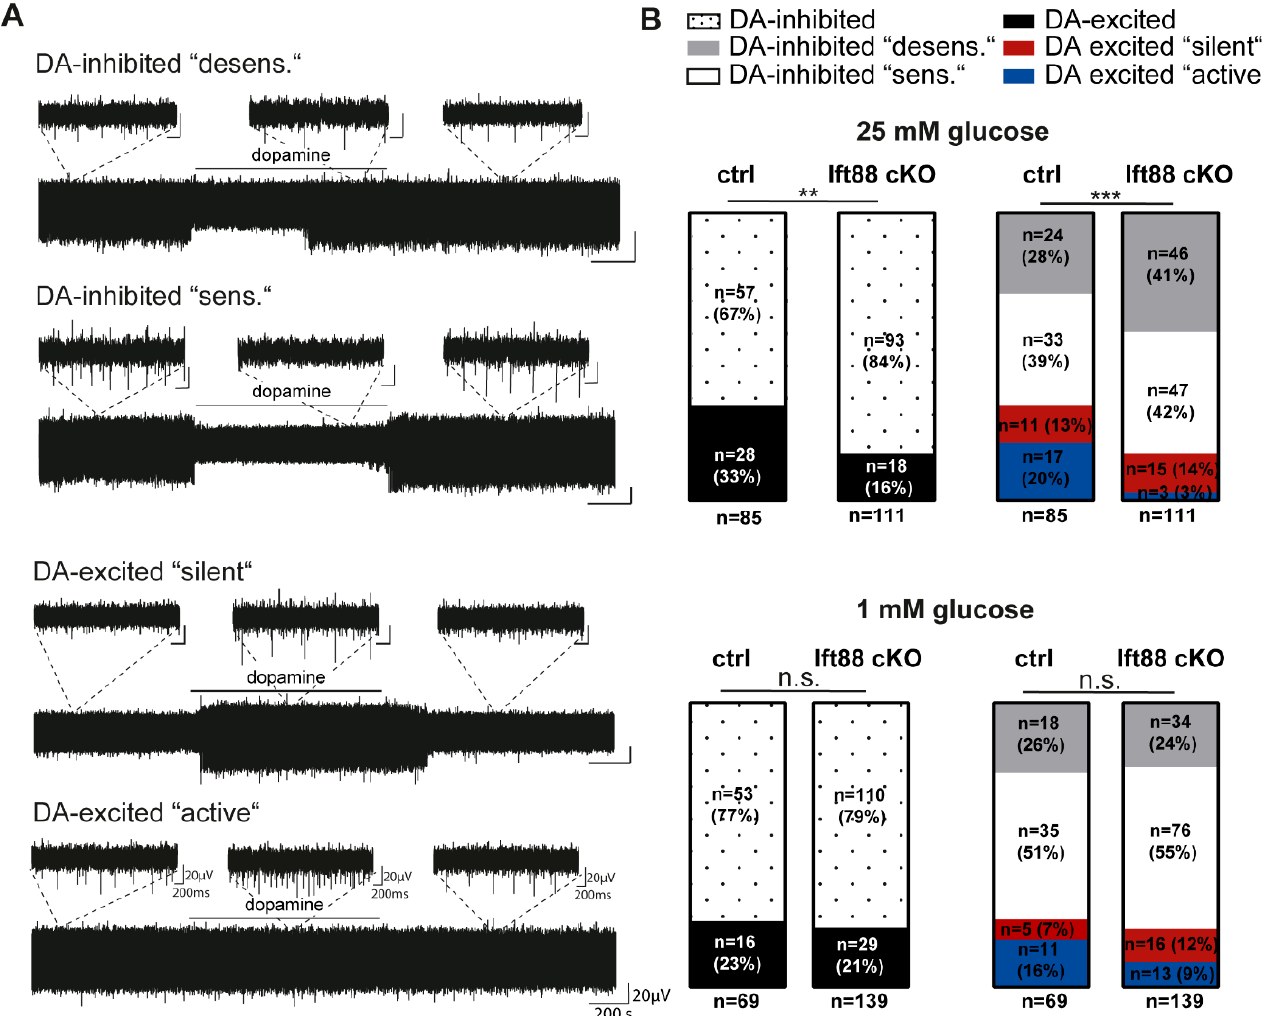
Figure 3. More SN neurons with inhibitory dopamine responses in Ift88 cKO mice . Spontaneous activities and responses to dopamine (in the figure abbreviated as DA, 100 µ M, bath applied for 15 min) of SN neurons in brain slices from adult controls and Ift88 cKO mice, recorded with multi-electrode array techniques (MEA) in ACSF, containing either 25 mM or 1 mM glucose, as indicated. ( A ) Exemplary traces of the four different types of dopamine responses of SN neurons, as described [5]. Inserts display enlarged traces of two seconds. ( B ) SN neurons were classified according to their dopamine responses in dopamine-inhibited cells (inhibited pacemaker activity in dopamine), and dopamine-excited cells (increased pacemaker frequency in dopamine) Dopamine-inhibited cells were subdivided in neurons with (“desens.”, grey) and without (“sens.”, white) prominent desensitization of dopamine responses over time. Dopamine-excited cells were subclassified in neurons without (“silent”, red) and with (“active”, blue) spontaneous activity before dopamine application. In saturated glucose (25 mM), Ift88 cKO mice displayed significantly more SN neurons with inhibitory dopamine responses (**, p = 0.0062), compared to controls (ctrl.), due to significantly lower numbers of dopamine-excited neurons of the “active” type (***, p = 0.0001). Statistical comparisons: chi-square tests. Number of analyzed neurons indicated by ( n ). All values and full statistics are detailed in the supplementary statistical information and Supplementary Table